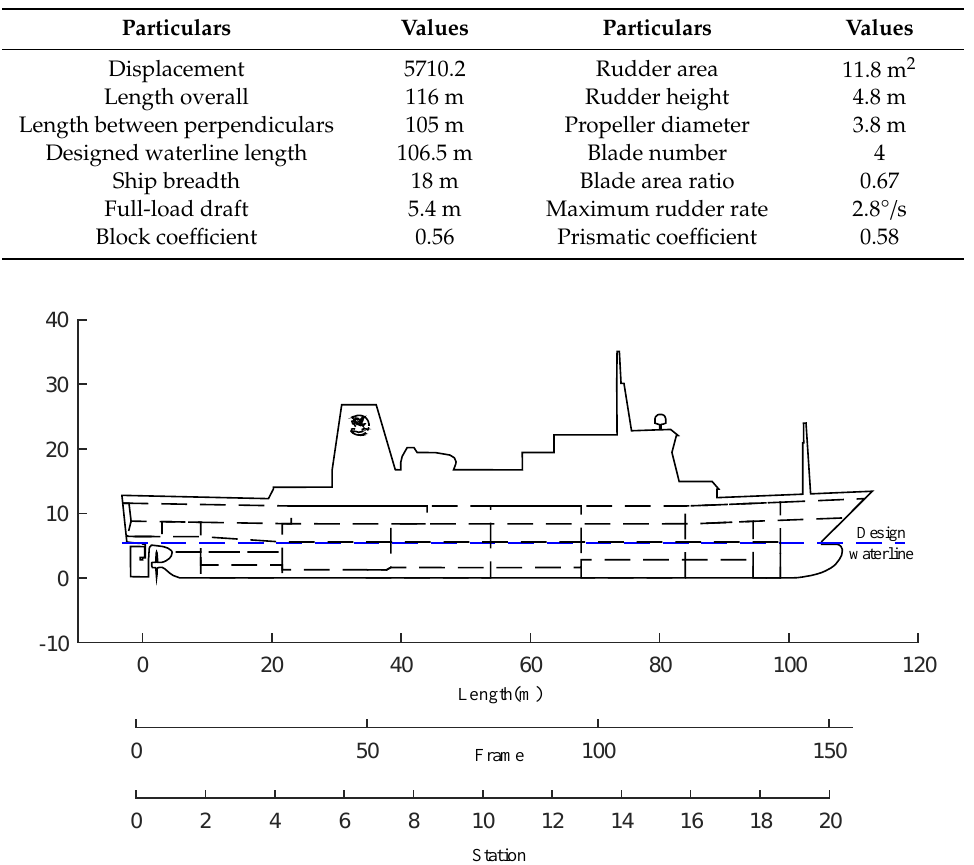
Figure 3. A general arrangement of Yukun motor vessel [29,30] (the figure permission has been achieved from Dalian Maritime University).